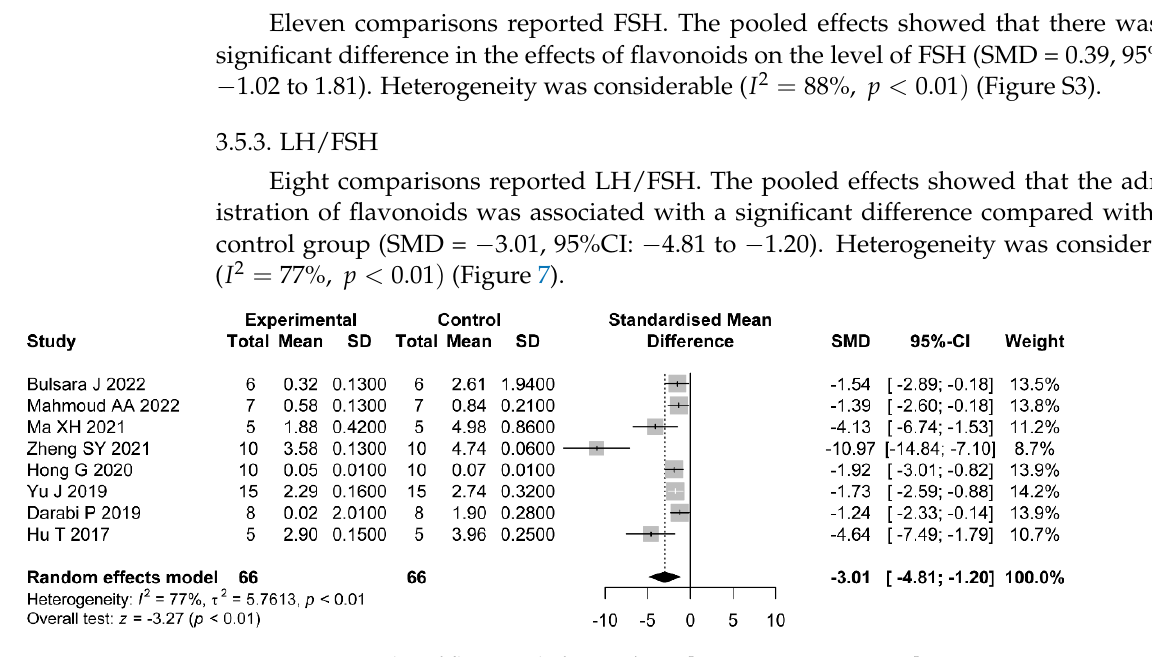
Figure 6. Forest plot of flavonoids for LH.